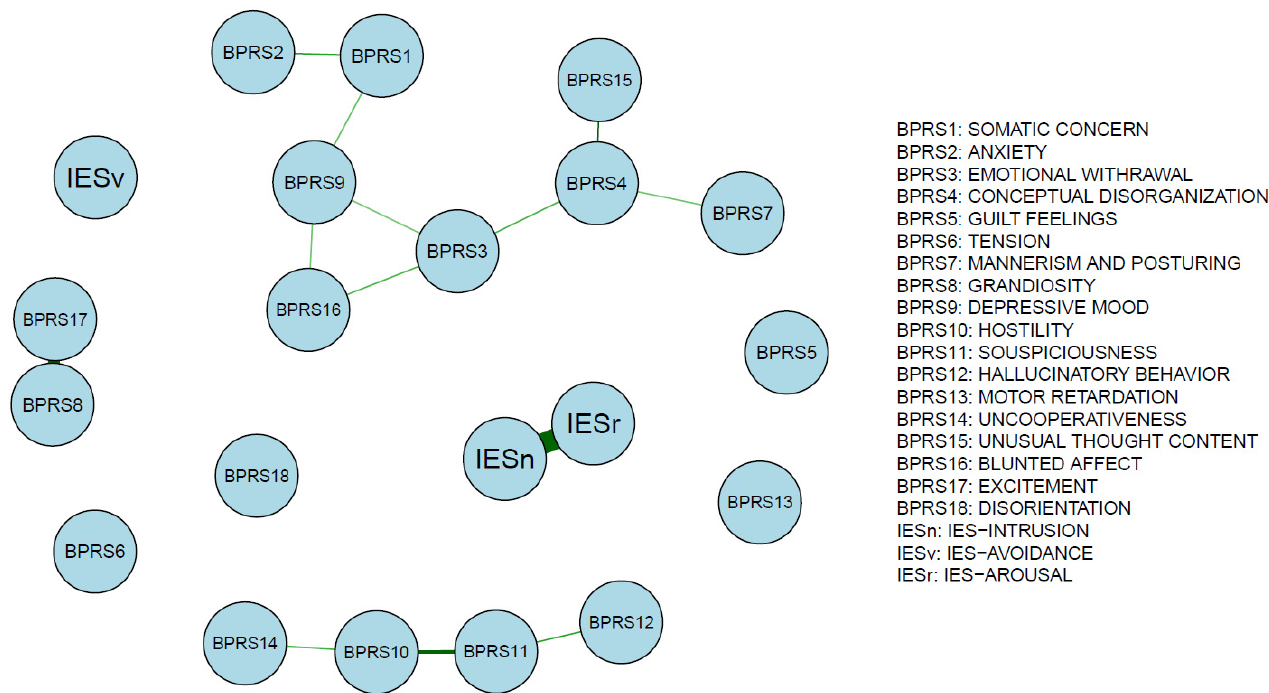
Figure 2. Network structure in the November sample. Edge weights reflect the connection strength of BPRS factors with IES-R dimensions in the November network.